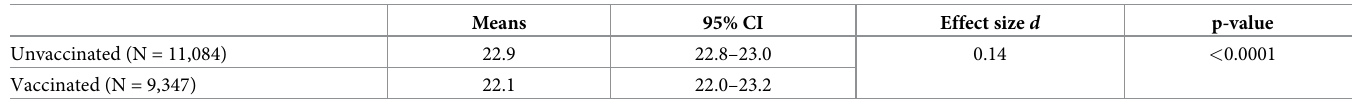
Table 1. Vaccinated vs.